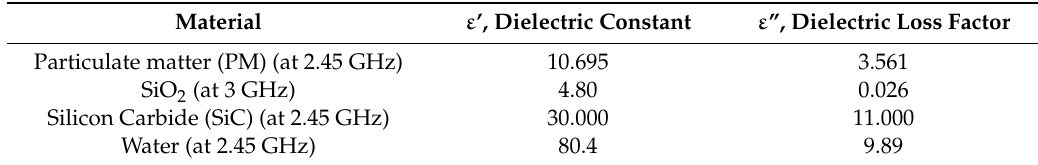
Table 3. Dielectric characteristics of various materials at 25 ◦ C [1]. Material ε ’, Dielectric Constant ε ”, Dielectric Loss Factor Particulate matter (PM) (at 2.45 GHz) 10.695 SiO 2 (at 3 GHz) 0.026 Silicon Carbide (SiC) (at 2.45 GHz) 30.000 Water (at 2.45